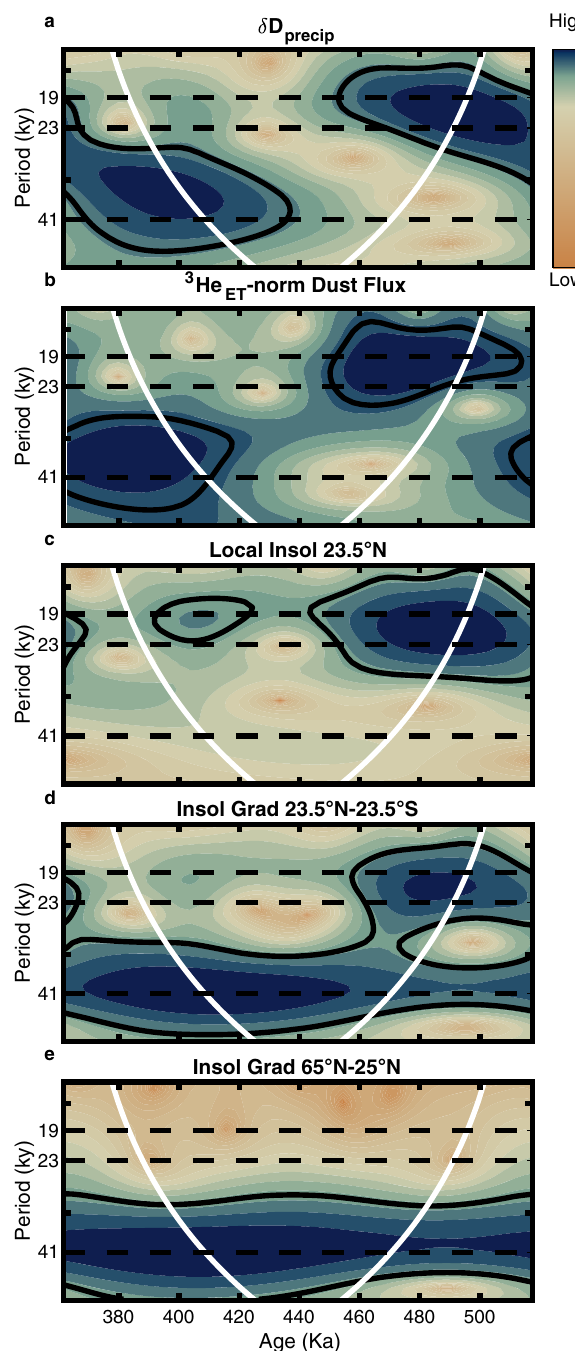
Fig. 2 δ D precip , dust fl ux, and insolation wavelet analysis. Wavelet scalograms depicting power at different periods through time for a δ D precip record, b 3 He ET- normalized dust fl ux, c local summer insolation, 23.5°N June 21, d summer inter-hemispheric insolation gradient 23.5°N – 23.5°S June 21, e low to high-latitude summer insolation gradient, 25°N – 65°N June 21. Continuous wavelet transforms were calculated following ref. 122 with all insolation time series sampled at wax isotope sample time points then interpolated to 3 kyr intervals. In all panels, the white parabola indicates the cone of in fl uence. Black solid lines encompass intervals with power that is signi fi cant at the 95% signi fi cance level. Only the cross-equatorial insolation gradient can explain both the precessional and obliquity-driven components of the δ D precip and the 3 He ET -normalized dust